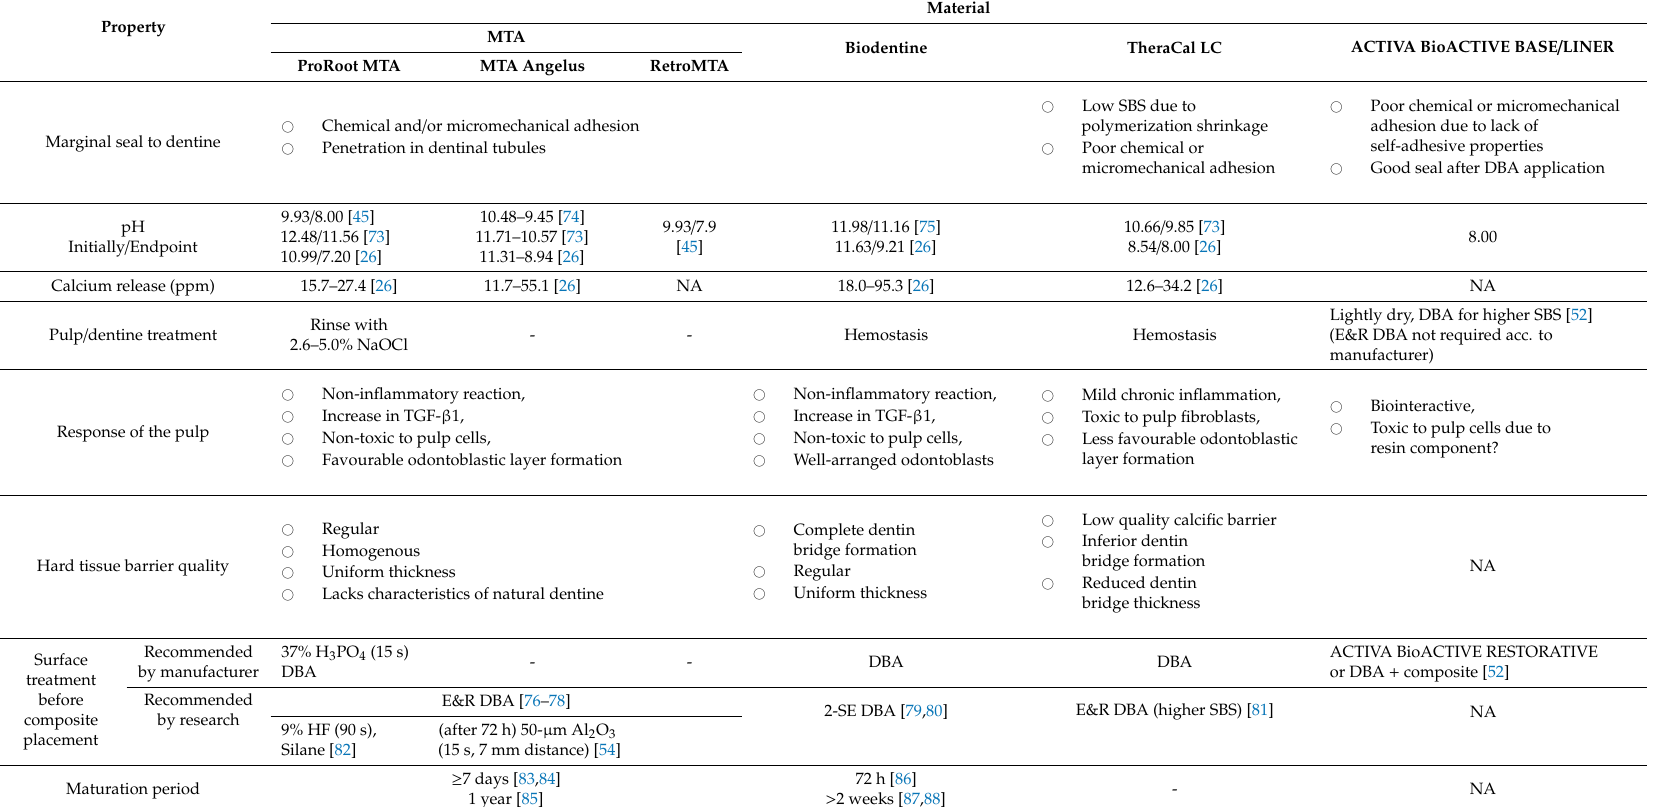
Table 3. Interfacial properties of bio-active